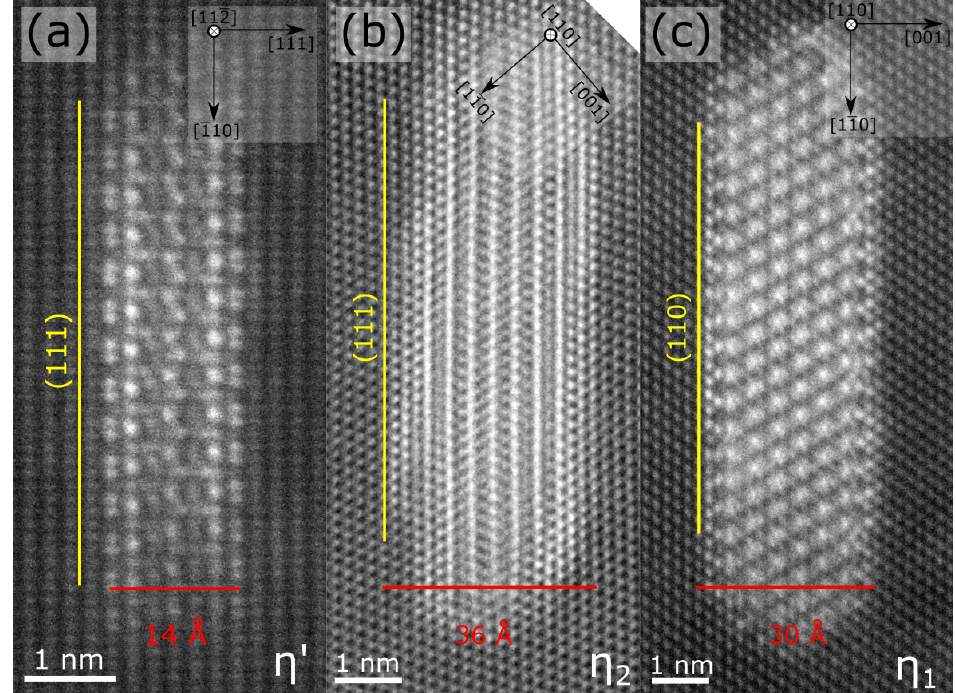
Figure 9. HAADF-STEM images of the different precipitates present in the conditions studied. ( a ) shows the η (cid:48) precipitate acquired in H-WQ-T6 along [11¯2] Al . ( b , c ) are the η 2 and η 1 precipitates, respectively, projected along [110] Al in sample H-WQ-T7. η (cid:48) and η 2 are present in T6. η 1 and η 2 are present in T7.